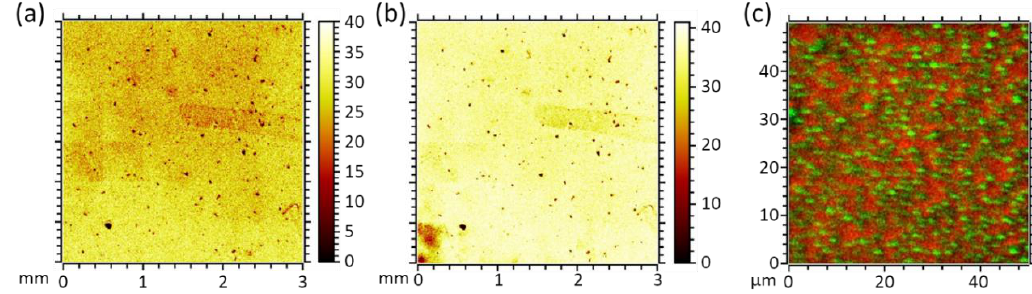
Figure 4. ToF-SIMS images of two characteristic PMMA fragments: ( a ) CH 3 O¯; ( b ) C 4 H 5 O 2 ¯; ( c ) ToF-SIMS red/green overlay image. Green: CN − , 26 m/z. Red: Sum of CH 3 O¯, 31 m/z, and C 4 H 5 O 2 ¯, 85 m/z. Scanning a 50 × 50 µm 2 field of view and recording 512 × 512 pixel, high lateral resolution images were obtained and combined into the red/green overlay (Figure 4c), showing the chemical contrast of SURGEL derived fragment CN − , green, and PMMA-derived fragments, red. Since the information depth of SIMS is in the range of a few nanometers, we concluded that the PS phase was fully removed during the solvent treatment and the pores in the topmost por-PMMA layer were open. The possibility to transfer the SURGEL membrane using a highly-porous, but still stable, transfer support layer of PMMA allowed us to directly use the por-PMMA/SURGEL composite system for the gas separation, without the need of an additional dissolution step in acetone, thus avoiding possible swelling of the PDMS layer, followed by shrinking when acetone evaporates. For the gas separation experiments, we employed both transfer techniques (por-PMMA and continuous PMMA) to compare the gas separation properties of the two transfer methods. 3.2. Gas Permeation Experiments For gas permeation experiments, we prepared thin film composite (TFC) membranes [28,35], comprised of PDMS/PAN and SURGEL, as selective layer. We chose the PDMS/PAN support to enhance the mechanical stability to the nanometer-thick SURGEL and minimize roughness-induced strain [30]. The PDMS layer also diminishes the effect of viscous gas flow through larger defects in the SURGEL layer. To evaluate the membrane properties of the individual SURGEL layer, we utilized the resistance model introduced by Henis and Tripodi [36]. In previous works, such an analysis has been successfully applied for the determination of properties of nanometer-thin CNMs [30] and CMPs [22]. We determined the gas transport properties of the reference and TCF-SURGEL samples (PDMS/PAN, SURGEL/PDMS/PAN and por-PMMA/SURGEL/PDMS/PAN) for He, H 2 , CO 2 , Ar, O 2 , N 2 , CH 4 , and C 2 H 6 . We chose these gases to cover a big range of kinetic diameters and molecular weights. Higher hydrocarbons were not used to avoid possible swelling of PDMS or the SURGEL layer during the exposure to the gas, which can damage the membranes. The measured gas permeances are presented as a function of penetrant kinetic diameters in Figure 5.